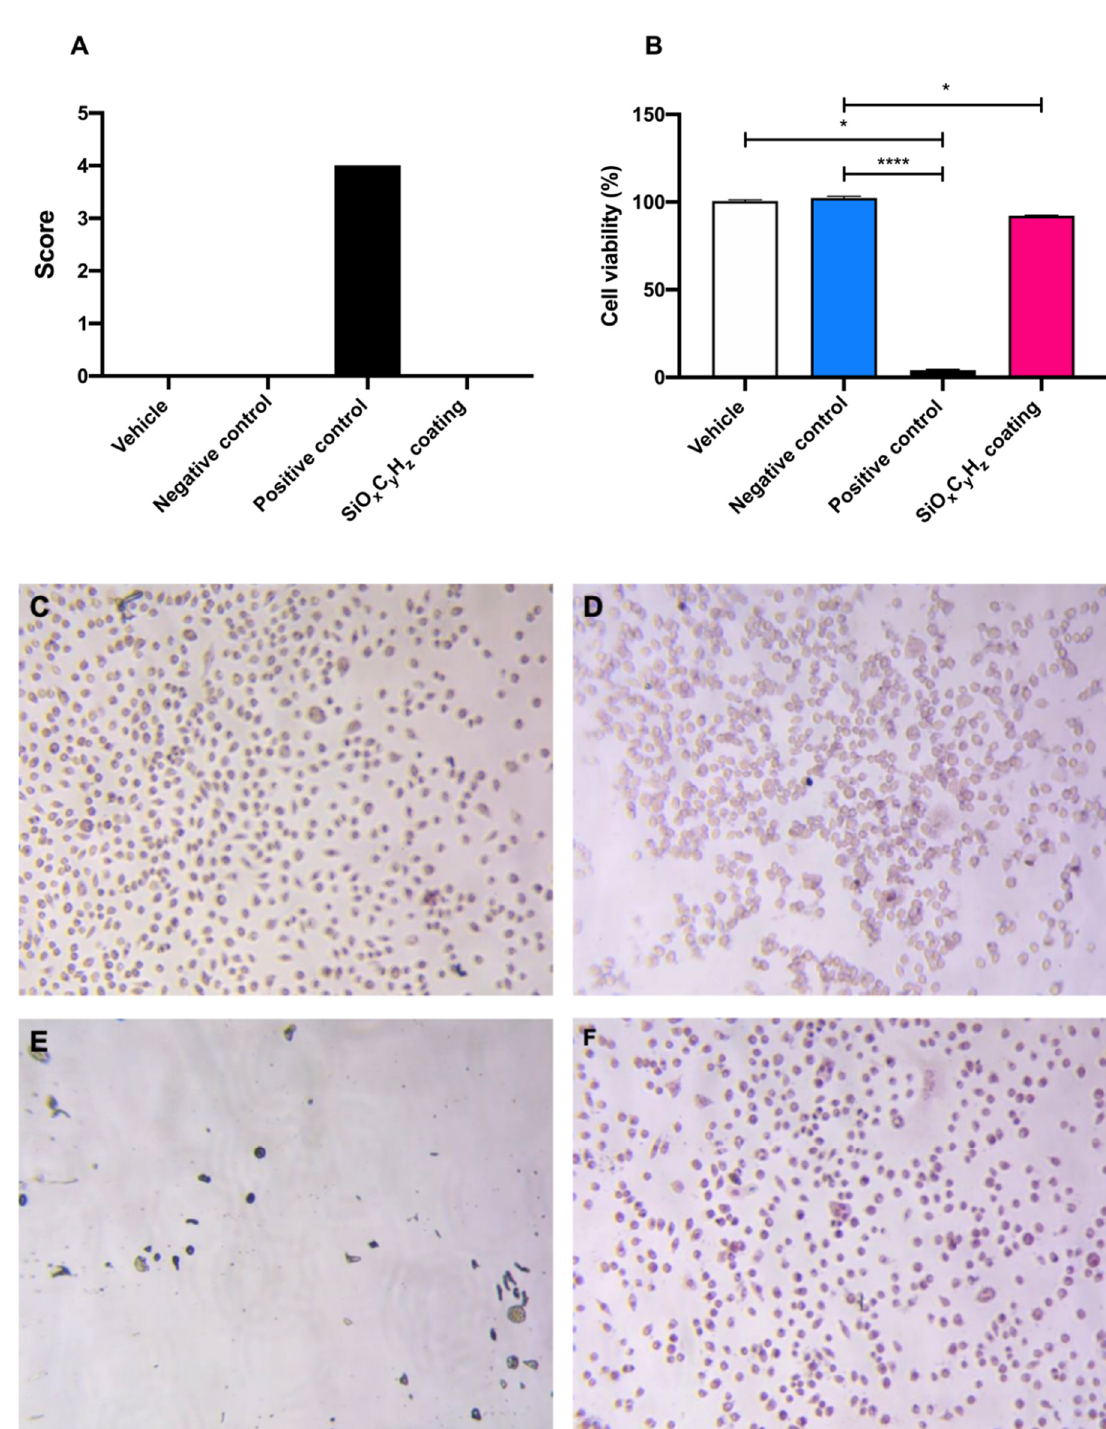
Figure 5. Graphical representation of ( A ) morphological grading score, ( B ) cell viability, and ( C – F ) microscopic images (10×) of vehicle, negative and positive control, and SiO x C y H z coating, respectively; * p < 0.05 and **** p < 0.0001.